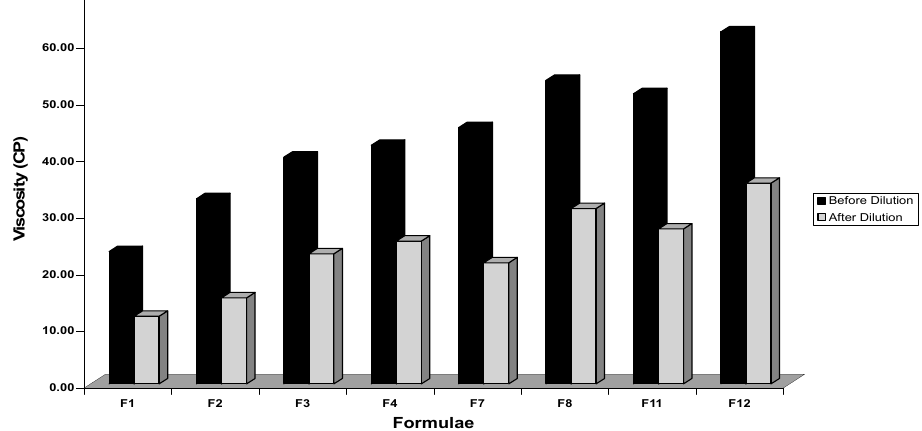
Figure 4. Plot of viscosity before and after dilution for various OLM SNEDDS formulae.